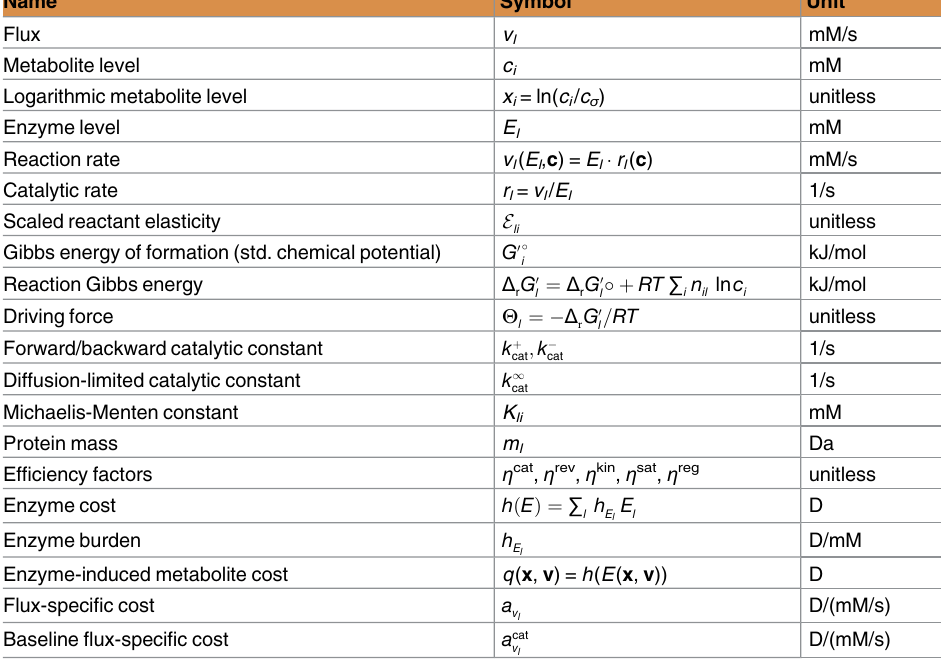
Table 1. Mathematical symbols used. The fitness unit Darwin (D) is a proxy for the different fitness units used in cell models. Reaction must be orientatedin such a way that all fluxes are positive. To define metabo- lite log-concentrations, we use the standard concentration c σ = 1 mM. For a more comprehensive list of math- ematical symbols used in ECM, see Table C in S1